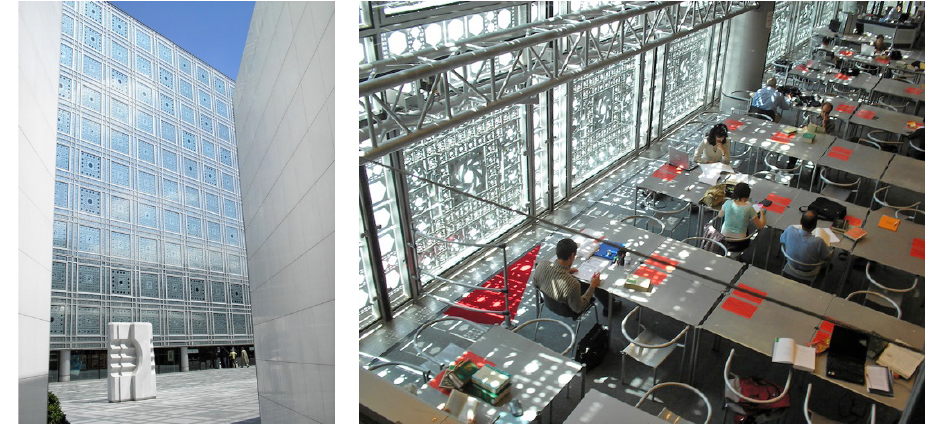
Figure 8. Arab World Institute in Paris, 1981−1987 (source: author, 2007)